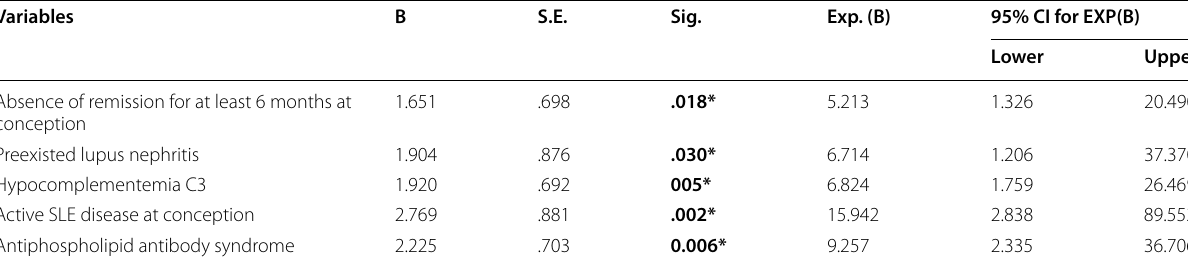
Hosmer and Lemeshow test ( P